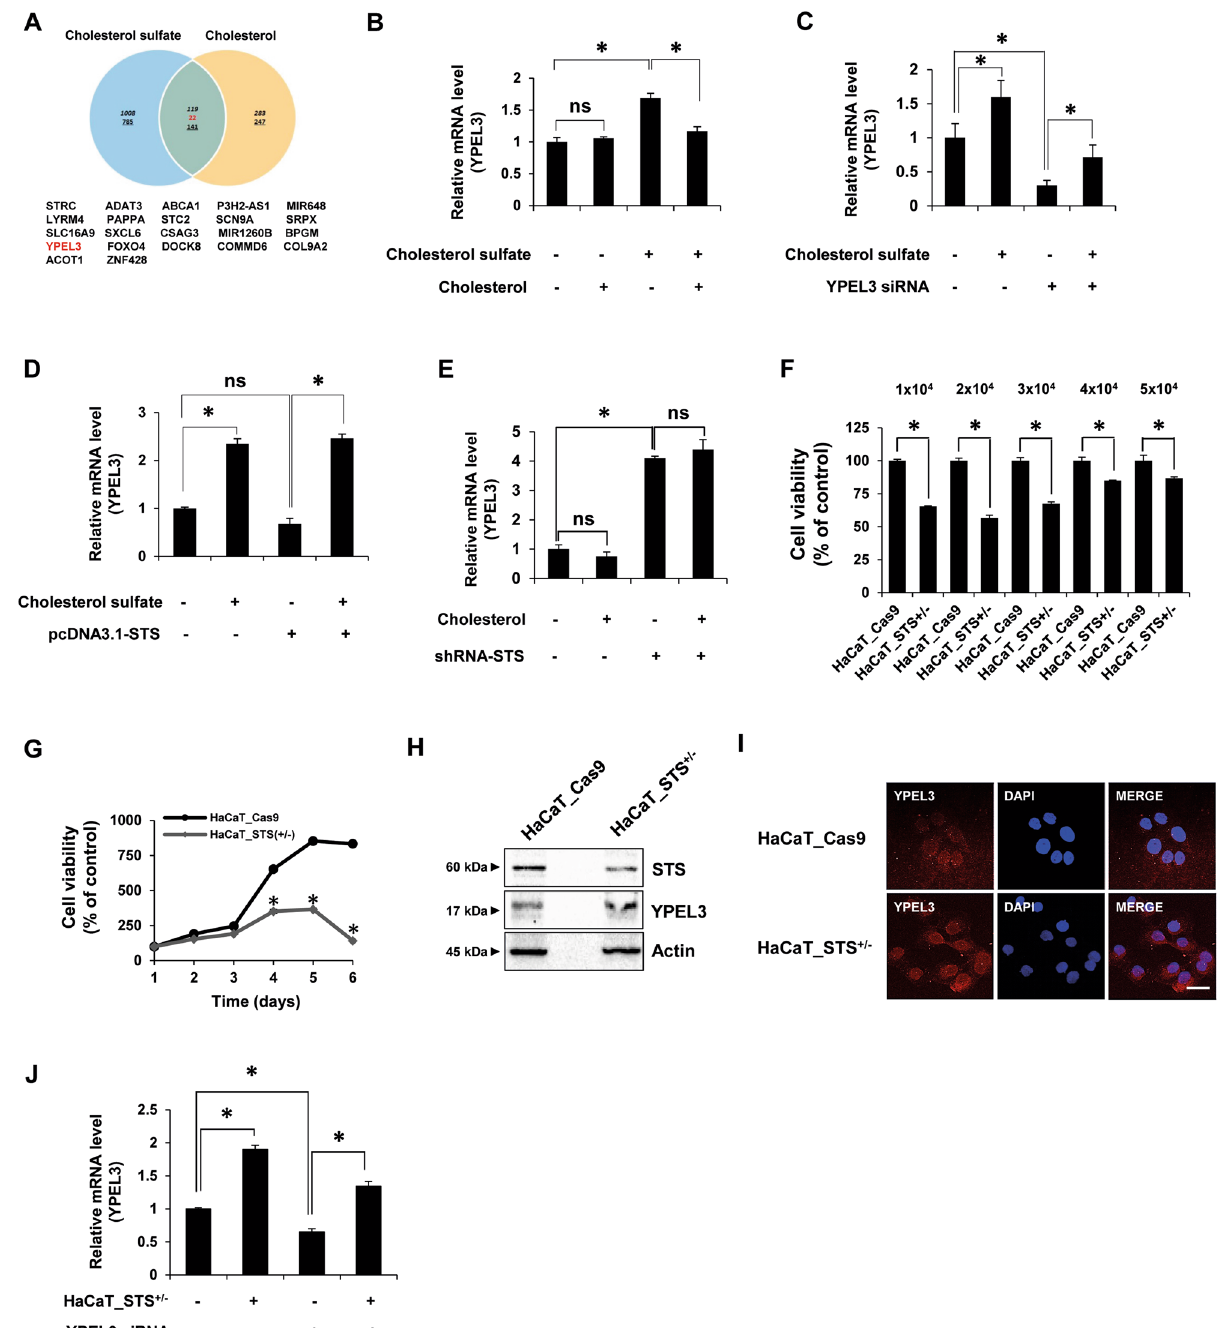
Figure 1. Cholesterol sulfate and STS deficiency induce YPEL3 expression in HaCaT cells. ( A ) Venn diagram of differentially expressed genes in the human keratinocytes HaCaT cell line after treated with cholesterol (20 μg/mL) or cholesterol sulfate (20 μg/ mL) for 24 h. The 22 genes that are most significantly up-regulated and down-regulated in the RNA-seq data sets are listed beside the venn diagram. Cut off ≥ 1.5 fold. ( B – E ) Real-time qPCR was performed to detect the expression of YPEL3 mRNA. ( B ) HaCaT cells were co-treated with cholesterol (20 μg/mL) and cholesterol sulfate (20 μg/mL) for 24 h. The data represent the mean ± SD (n = 3). ( C ) HaCaT cells were transfected with YPEL3 siRNA (50 nM) for 24 h and then treated with cholesterol sulfate (20 μg/mL) for 24 h. The data represent the mean ± SD (n = 3). ( D ) HaCaT cells were transfected with pcDNA3.1-STS (3 μg) for 24 h and then treated with cholesterol sulfate (20 μg/mL) for 24 h. ( E ) STS knock-down HaCaT cells were treated with cholesterol (20 μg/mL) for 24 h. The data represent the mean ± SD (n = 3). ( F – J ) HaCaT_STS +/− cell line was constructed using the CRISPR/Cas9 system in HaCaT cells. ( F ) HaCaT_STS +/− cells were seeded at 1, 2, 3, 4, or 5 × 10 4 cells/well in a 24-well plate and incubated in medium containing 10% FBS for 72 h. Cell viability was measured using CCK assay. The data represent the mean ± SD (n = 3). ( G ) HaCaT_STS +/− cells were incubated with 10% FBS + DMEM medium for 6 days. Cell viability was measured using CCK assay. The data represent the mean ± SD (n = 3). ( H ) STS and YPEL3 protein levels were measured using western blot analysis. ( I ) Confocal analysis was performed to assess YPEL3 expression. Microscopy scale bar = 50 μm. ( J ) HaCaT_STS +/− cells were transfected with YPEL3 siRNA (50 nM) for 48 h. Real-time qPCR was performed to detect the expression of YPEL3 mRNA. The data represent the mean ± SD (n = 3). *p <